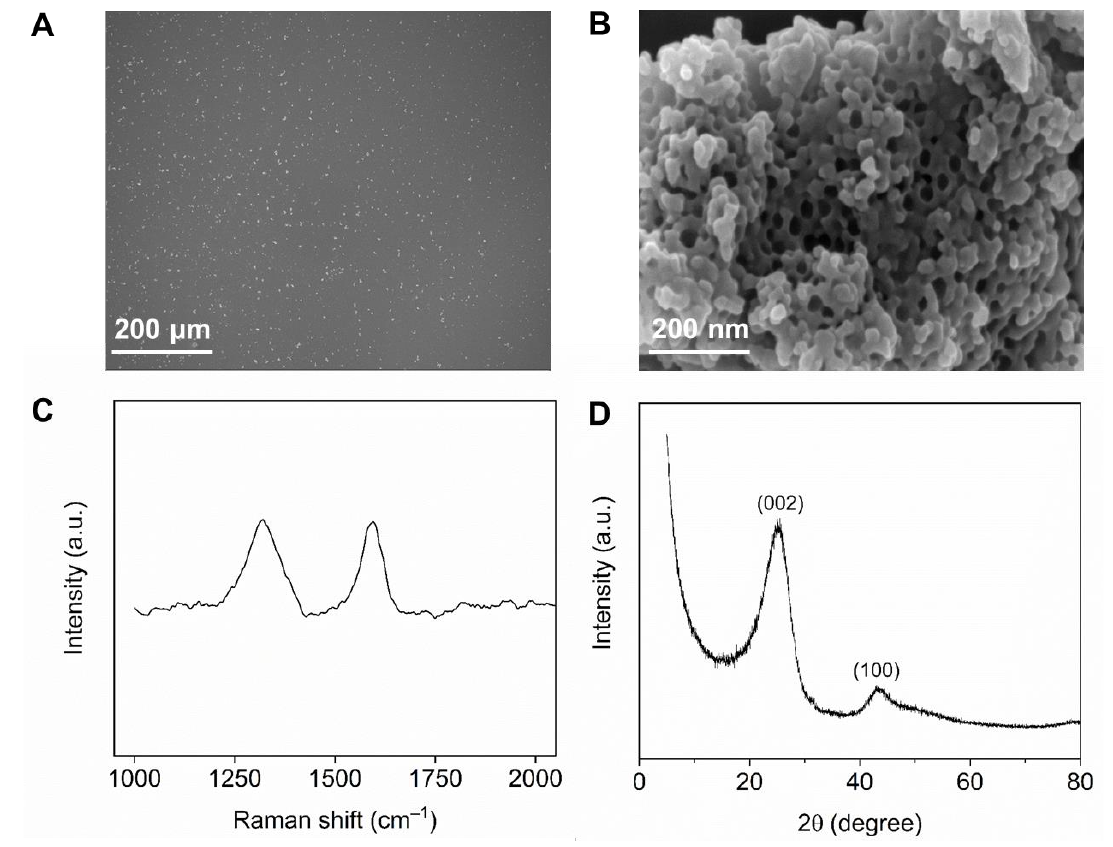
Figure 1. ( A , B ) Scanning electron microscope images, ( C ) Raman spectra of the NPC, and ( D ) X-ray diffraction pattern.